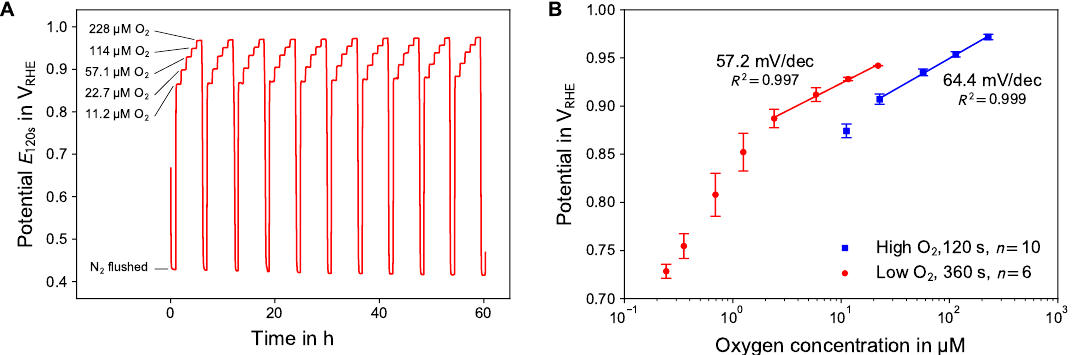
Figure 4. ( A ) Trace of active potentiometry measurements of 10 consecutive concentration ramps with higher oxygen concentrations. ( B ) Calibration curves for the concentrations ramp with higher and lower oxygen concentration range. In case of lower oxygen concentrations (red disks) the OCP phase was prolonged to 360s.